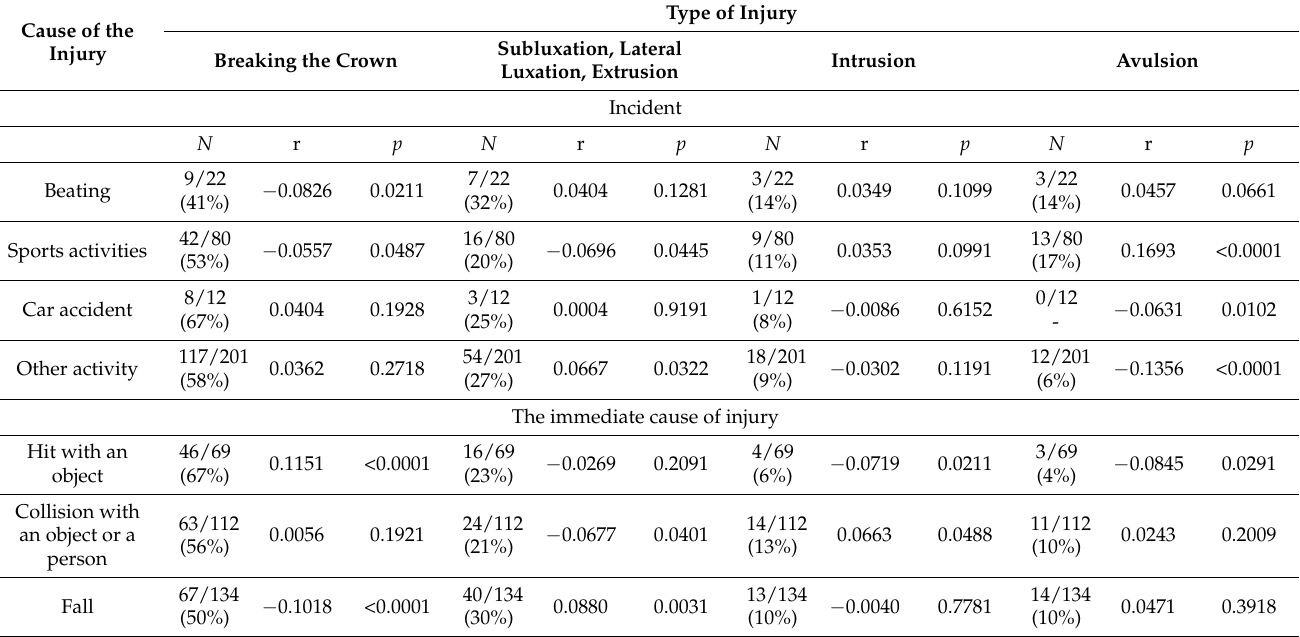
Table 2. Correlations between type of injury and cause of injury (Spearman’s r-correlation coefficient).